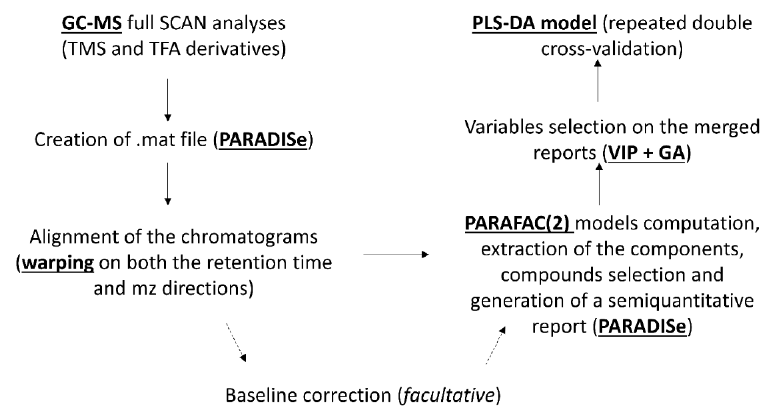
Figure 1. Statistical analysis workflow.